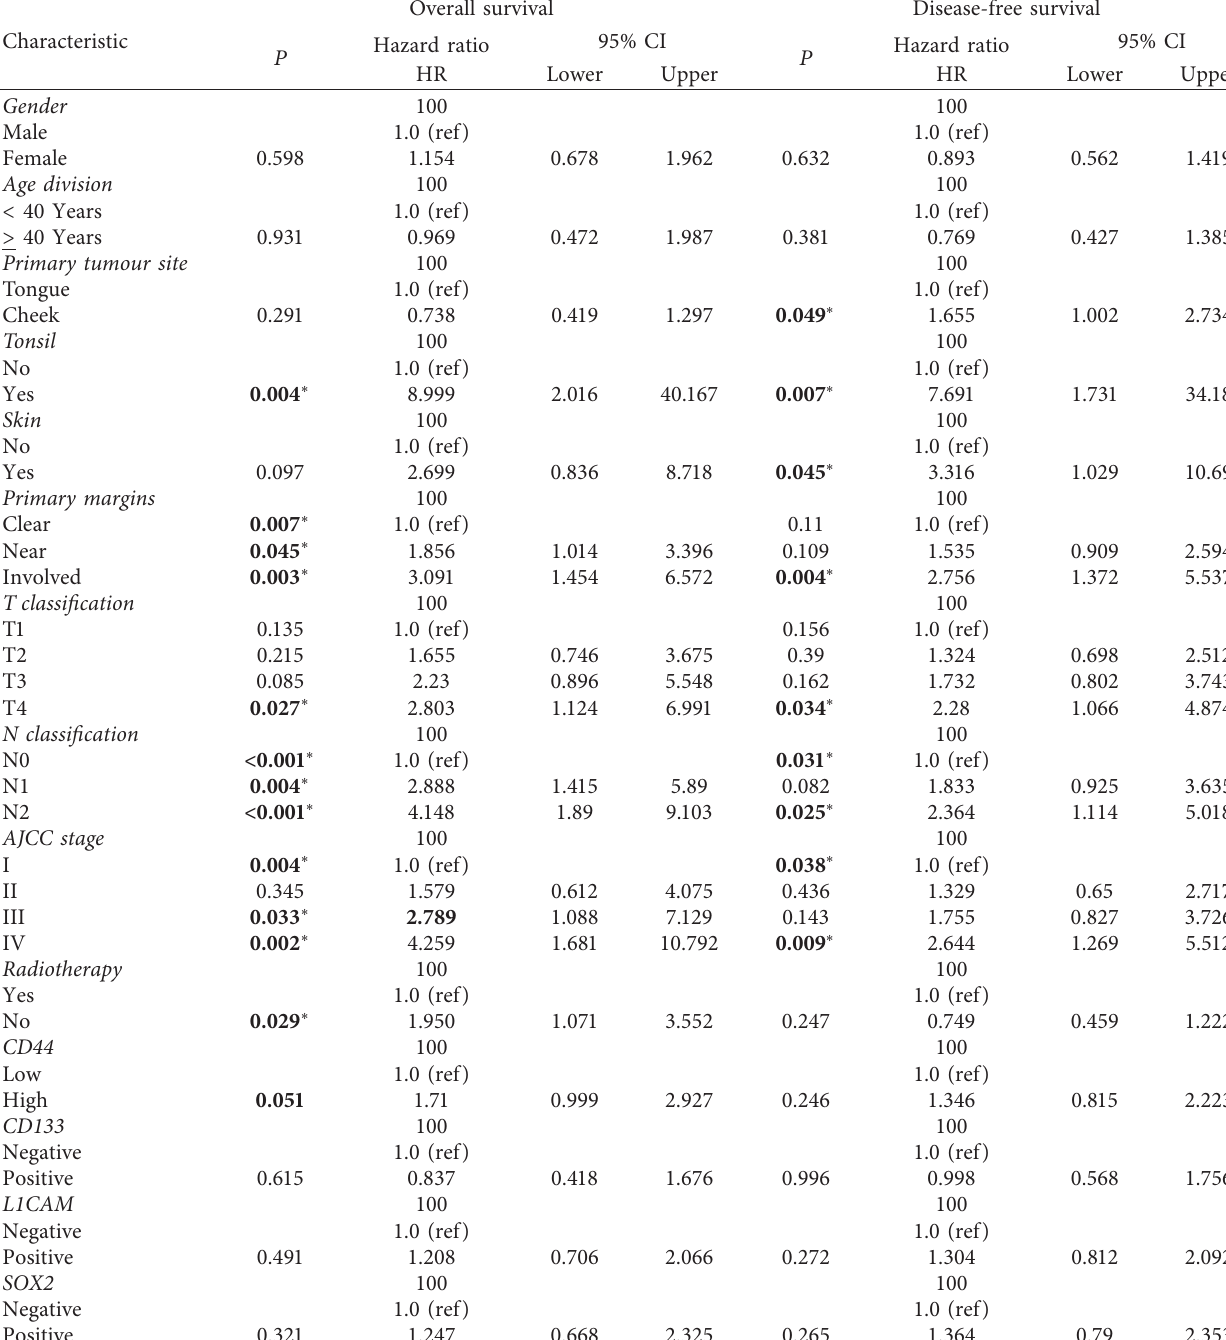
Table 6: Cox regression univariate analysis ( n �